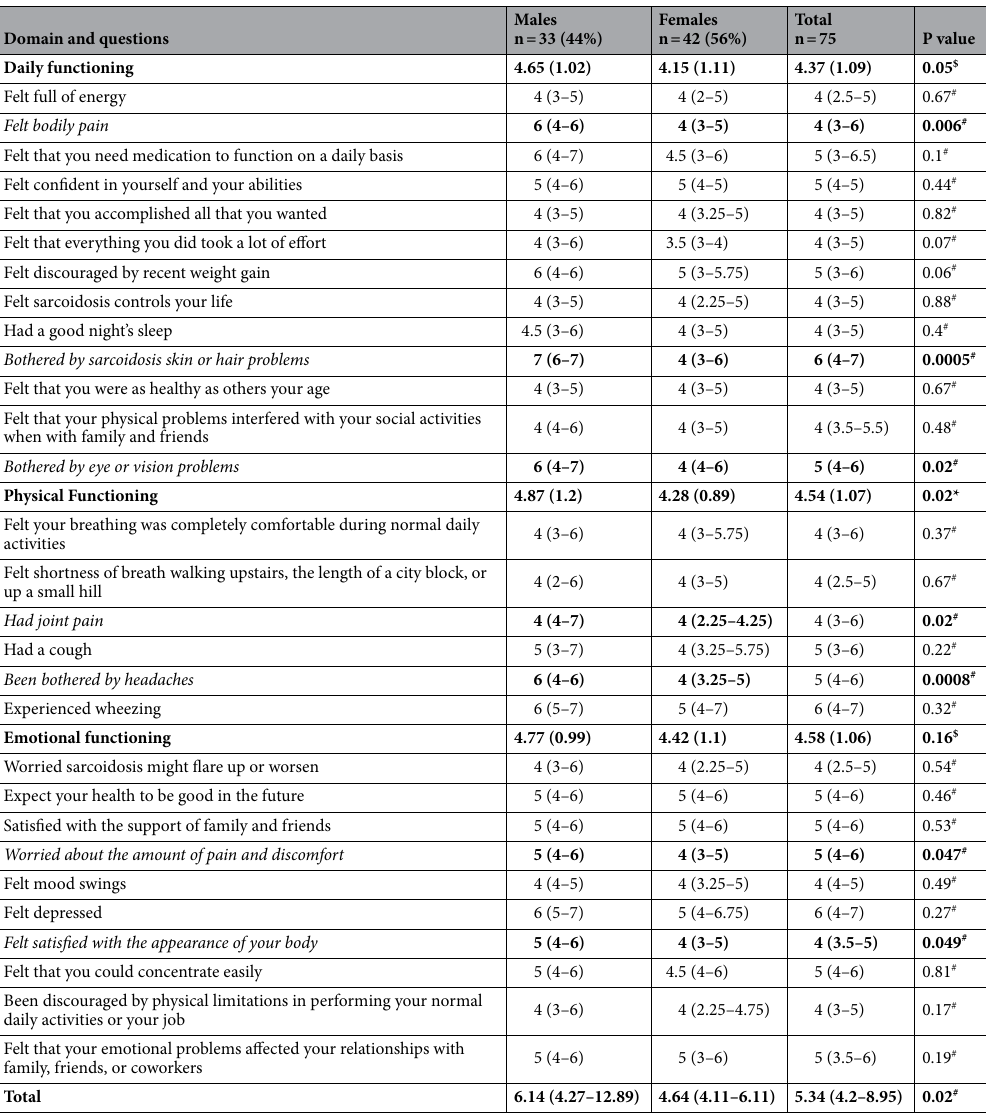
Table 2. Sarcoidosis health questionnaire items by domain, stratified by gender. Data are presented as mean (SD) or median (IQR). Presented P values are for: # Wilcoxon rank sum test, $ Student or *Welch t